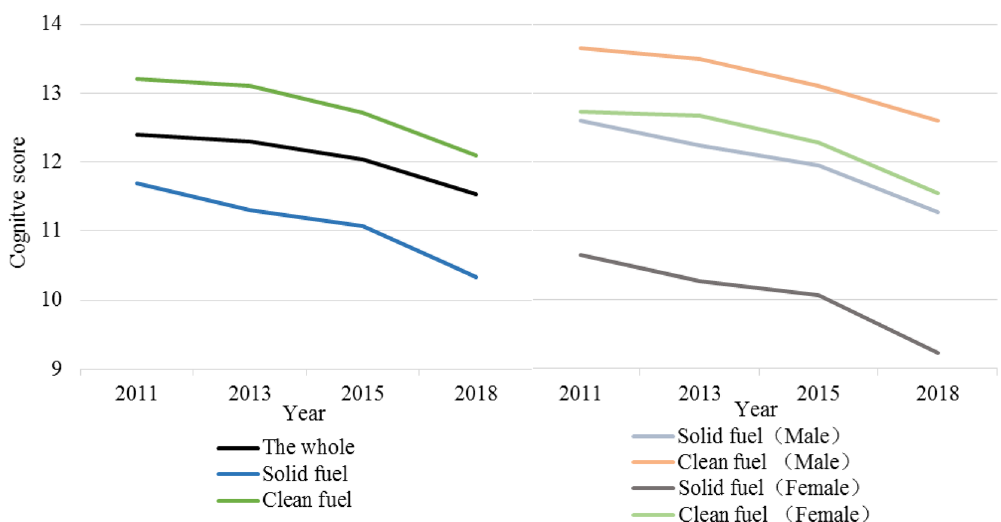
Figure 2. Cognitive change in the participants during the follow-up period.